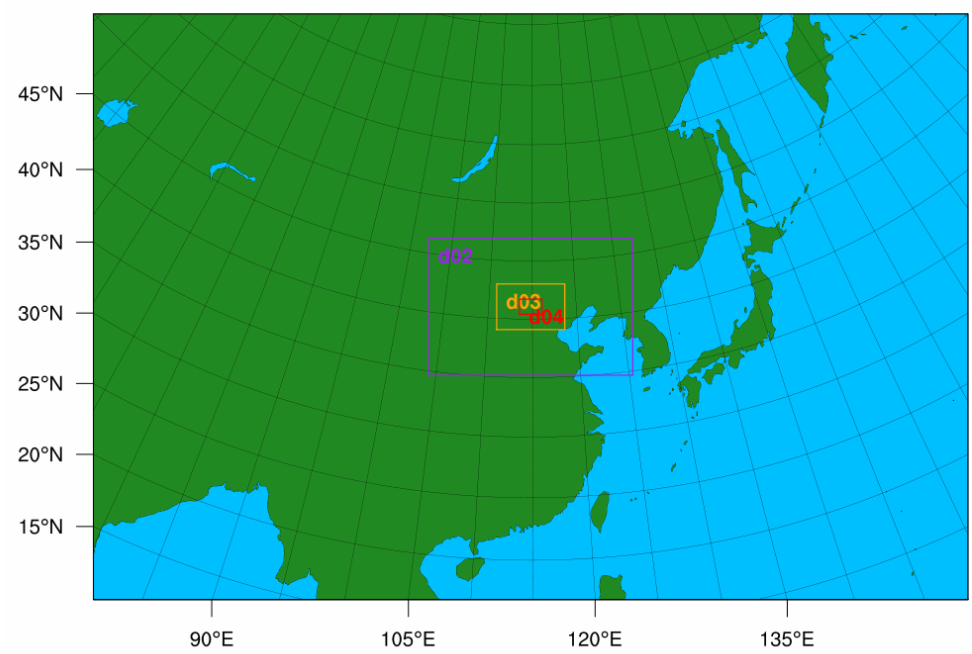
Figure 1. Weather Research and Forecasting Pre-Processing System domain configuration used for the numerical weather forecasts over the wind farm. The four nested domains (centred on the location of the wind farm) are labelled as d01 (the coarsest corresponding to the entire domain), d02, d03, and d04 (the